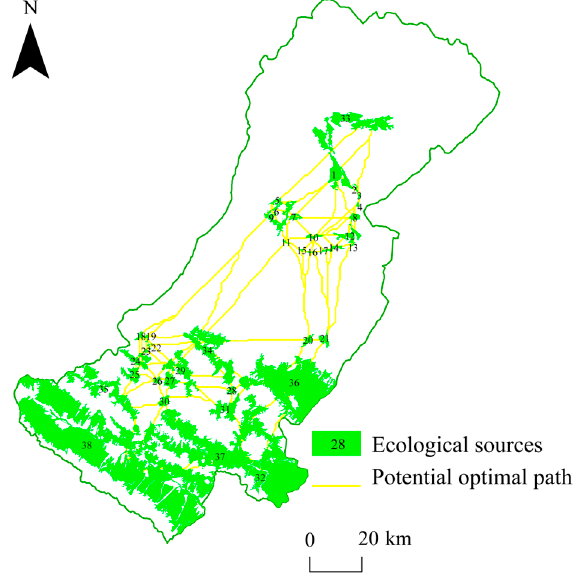
Figure 6. Distribution of “source” and Shortest Path.